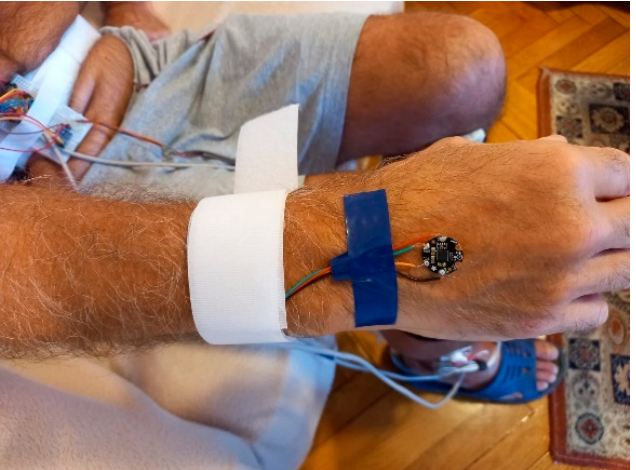
Figure 6. Illustration of the attachment of the LSM9DS0 accelerometer to the user’s right wrist, for arm balance tracking during the gait cycle.